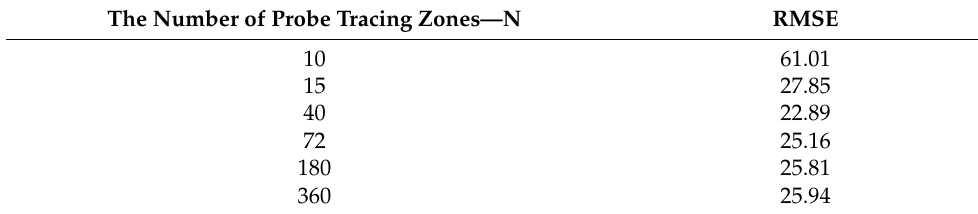
Table 2. Tracking error change table under each time zone.